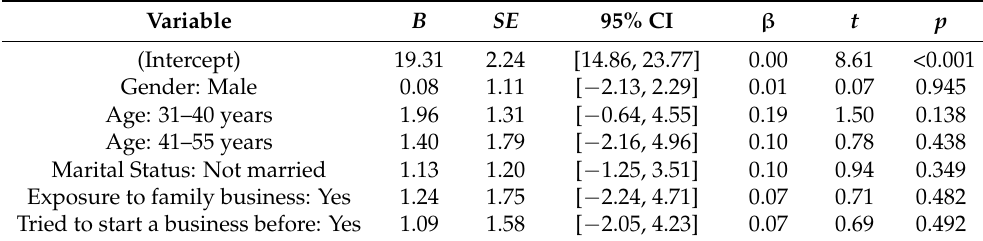
Table 3. Results for linear regression with demographic variable predicting sustainable entrepreneur- ship